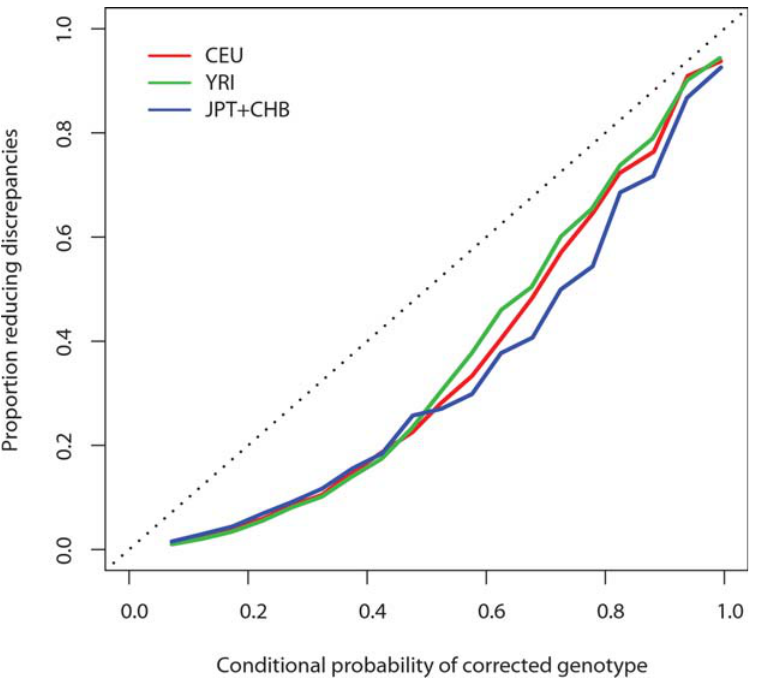
Figure 4. Calibration of conditional probabilities of corrected genotypes in the Affymetrix data. Separately in 3 HapMap populations and for all 22 autosomes, we calculated the conditional probabilities of genotypes other than the observed genotype calls. We then binned these probabilities and, within each bin, calculated the proportion of genotypes which, if switched to the most-probable genotype other than that observed, resulted in a decrease in the number of discrepancies with the HapMap calls.